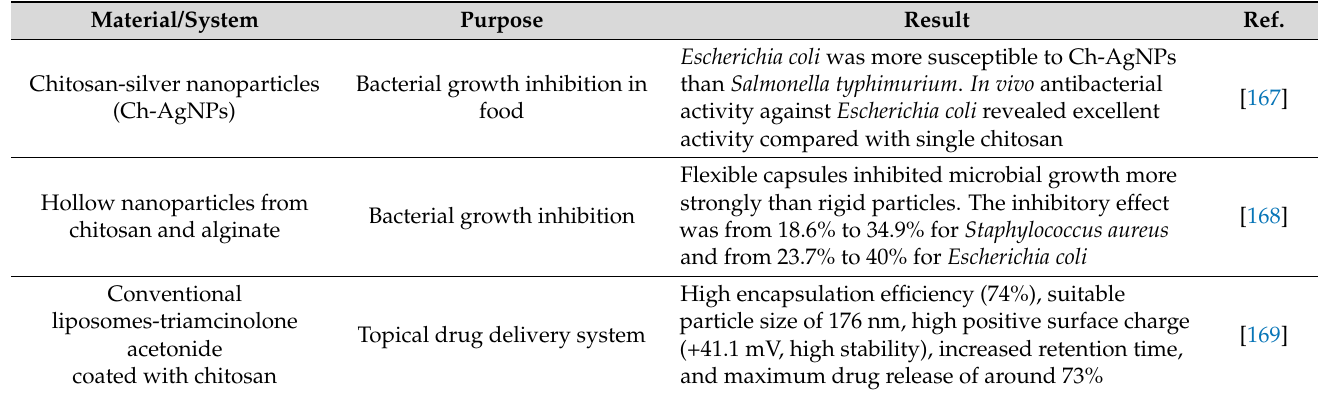
Table 1. Summary of representative results obtained with chitosan-based materials in different